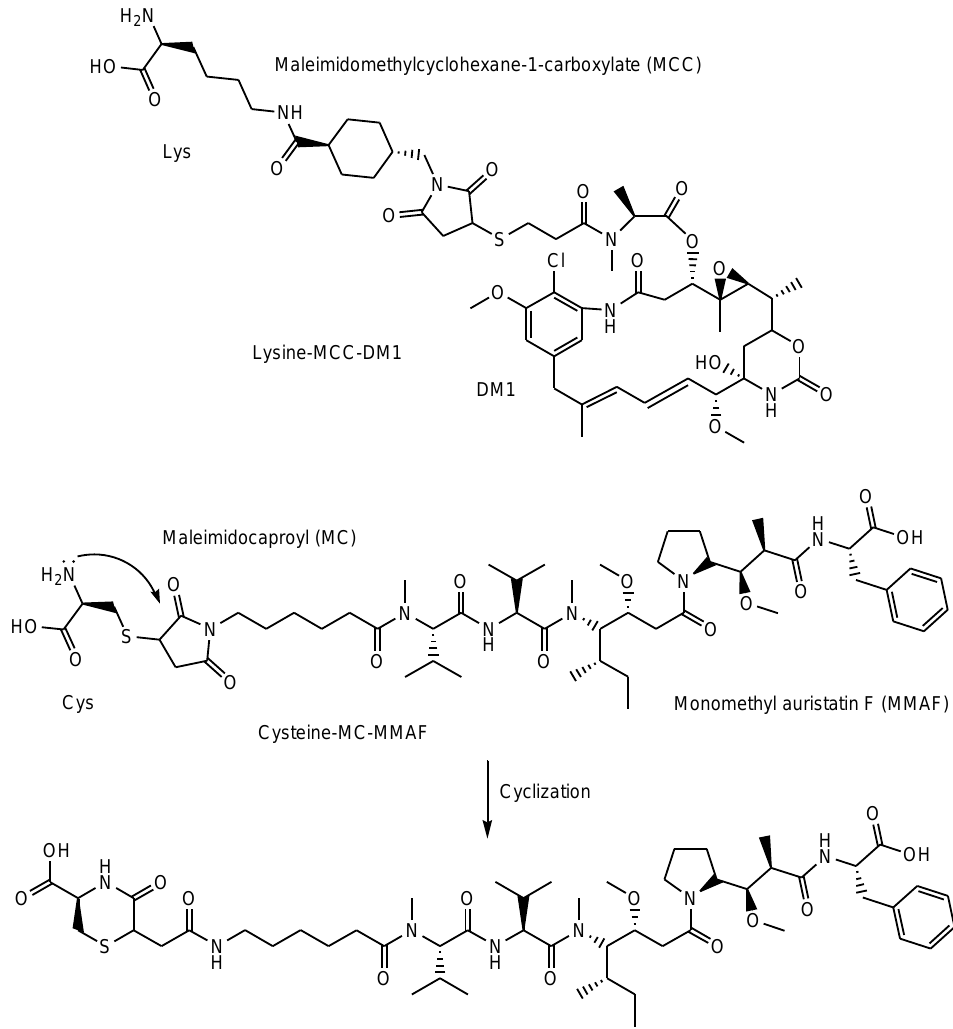
Figure 4. The structures of lysine-MCC-DM1 and cysteine-MC-MMAF as catabolites in lysosomes, and the cyclic form of cysteine-MC-MMAF.